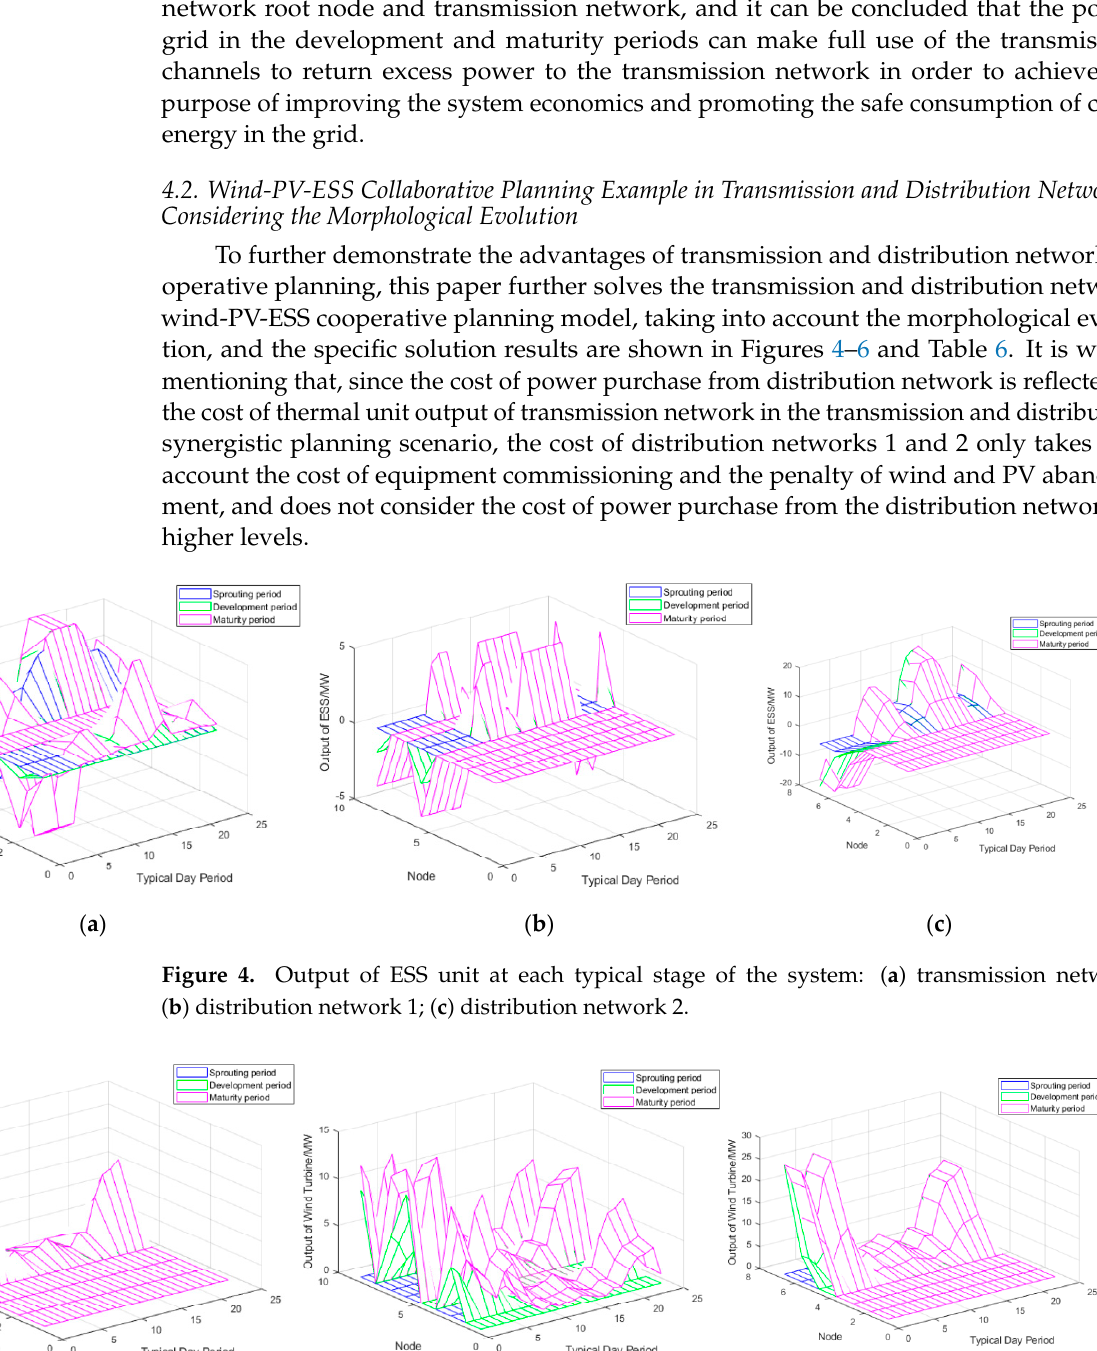
Table 6. Collaborative planning scheme for wind-PV-ESS of transmission and distribution network in different periods.